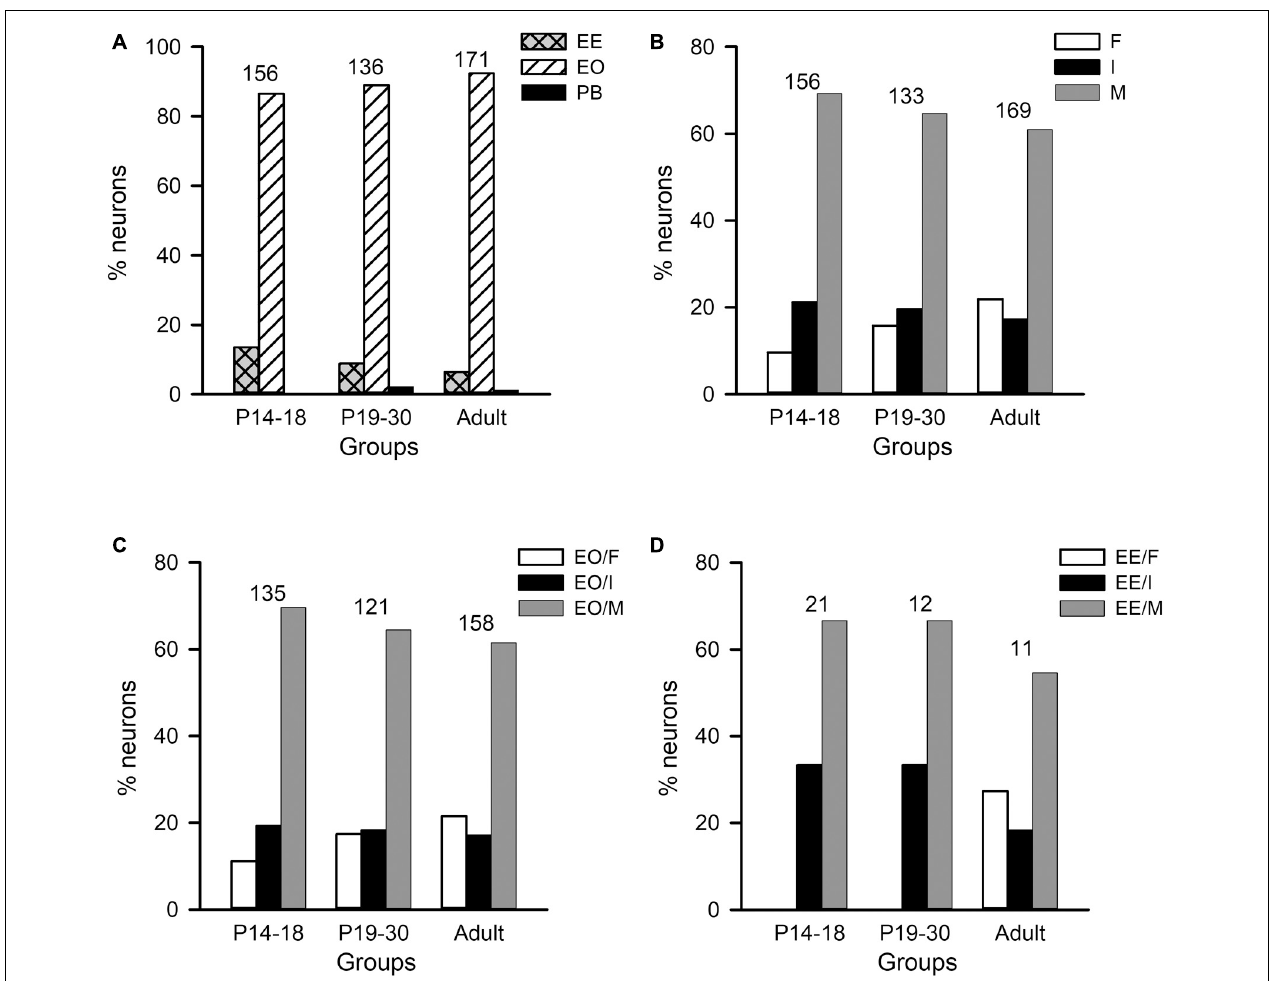
FIGURE 6 | Distributions of the monaural response types and the binaural interaction types of AI neurons in the three age groups of rats. The three age groups are P14–18 group, P19–30 group, and adult group, respectively. (A) The distributions of the monaural response types (i.e., EE, EO, and PB) of AI neurons. (B) The distributions of the binaural interaction types for the population including both EO and EE neurons. The binaural interaction of each neuron was classified into one of the three categories: inhibitory (I), facilitatory (F), and mixed (M). (C,D) The distributions of the binaural interaction types in the population of EO neurons (C) and EE neurons (D) . Numbers shown on the top of the bars indicate the number of neurons in each age group.